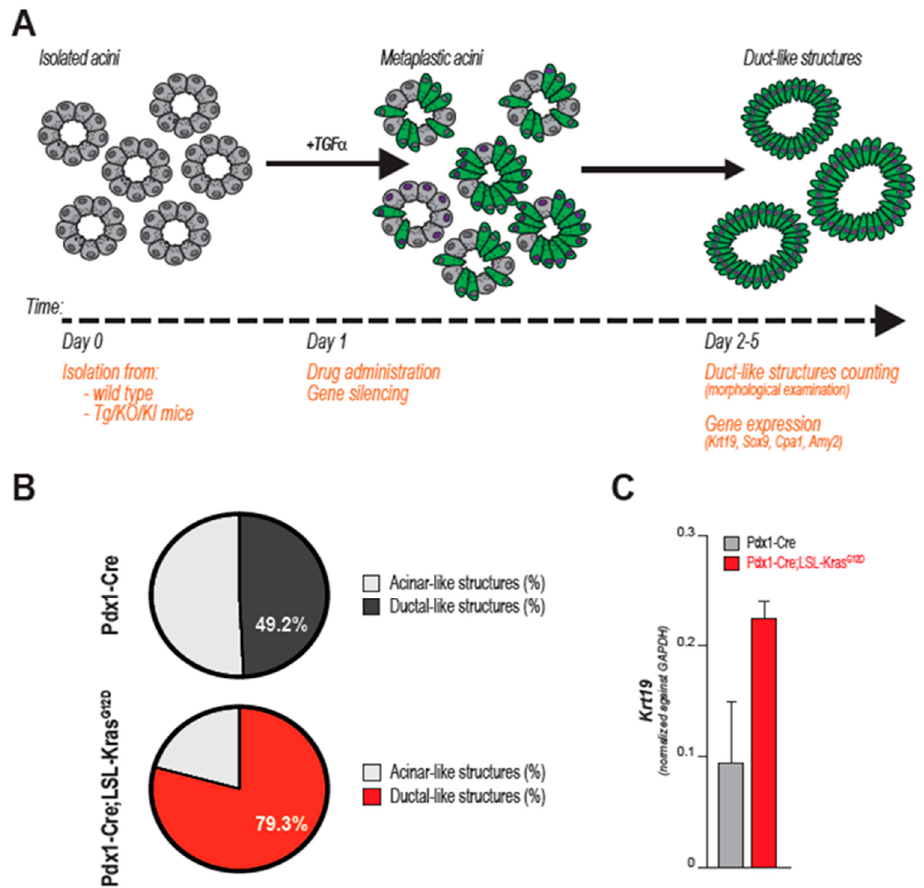
Figure 3. Ex vivo acinar-to-ductal metaplasia (ADM) as a model for PDA initiation. In ( A ) schematic representation of ADM from acinar explants. Once isolated, acinar cells undergo transdi ff erentiation to acquire morphological and molecular features typical of ductal cells. Gene mutations (i.e., KRAS ) and growth factors (i.e., TGF α , EGF) induce ADM ex vivo. The impact of additional genetic aberrations, signaling events or chemical compounds can be examined by several means (listed in orange): the ability to form ductal-like structure can be evaluated at end point, as shown in B and C. In this way, impact for tumor initiation can be inferred. In ( B , C ), two di ff erent metrics to score the tumor-initiating potential of KRAS mutation. In ( B ) percentage of acinar- and ductal-like structures is assessed by morphological evaluation of multiple samples. Acinar cells derived from Pdx1-Cre ; LSL-KrasG12D (KC) mice form significantly more duct when cultured ex vivo (day 2 post isolation, in Matrigel). Percentage in white indicates the fraction of duct-like structures arising from cultures of acinar cells derived from either Pdx1-Cre or KC mice (on the total number of multi-cellular structures analyzed). In ( C ) quantitative PCR shows increased expression of duct-specific Cytokeratin-19 ( Krt19 ) in cultures derived from either Pdx1-Cre or KC pancreata (at day 2 post isolation, in Matrigel, triplicates).